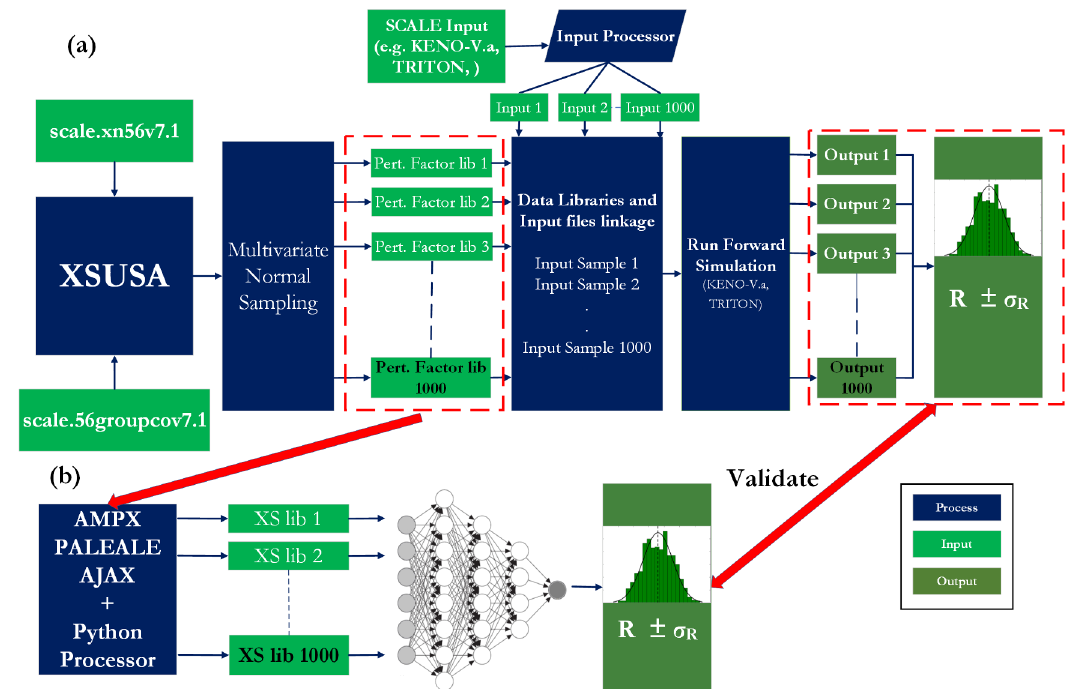
Figure 1: Flowchart of (a) sampling nuclear data in SCALE/Sampler and (b) the connection with machine